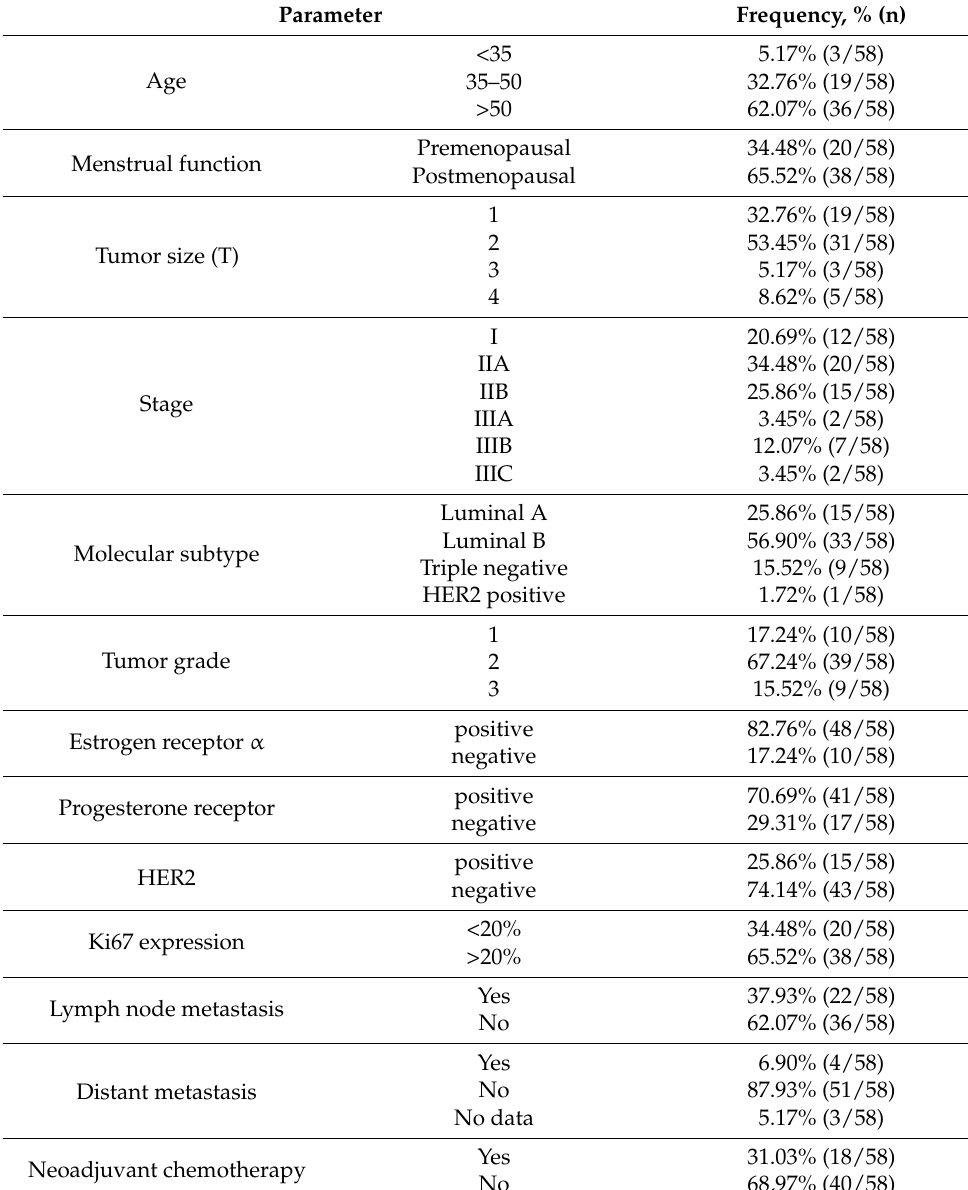
Table 1. Clinicopathological characteristics of